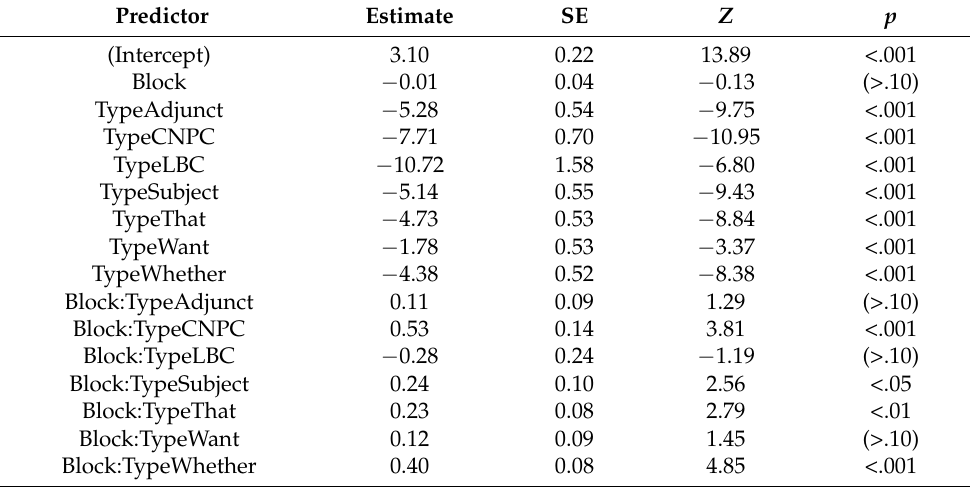
Table 3. Table of fixed effects for Experiment